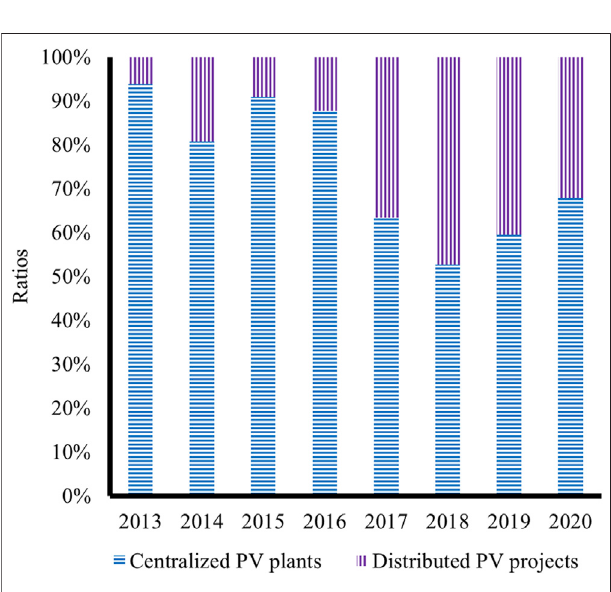
FIGURE 3 | Proportion of new installed capacity of centralized PV and distributed PV in China from 2013 to